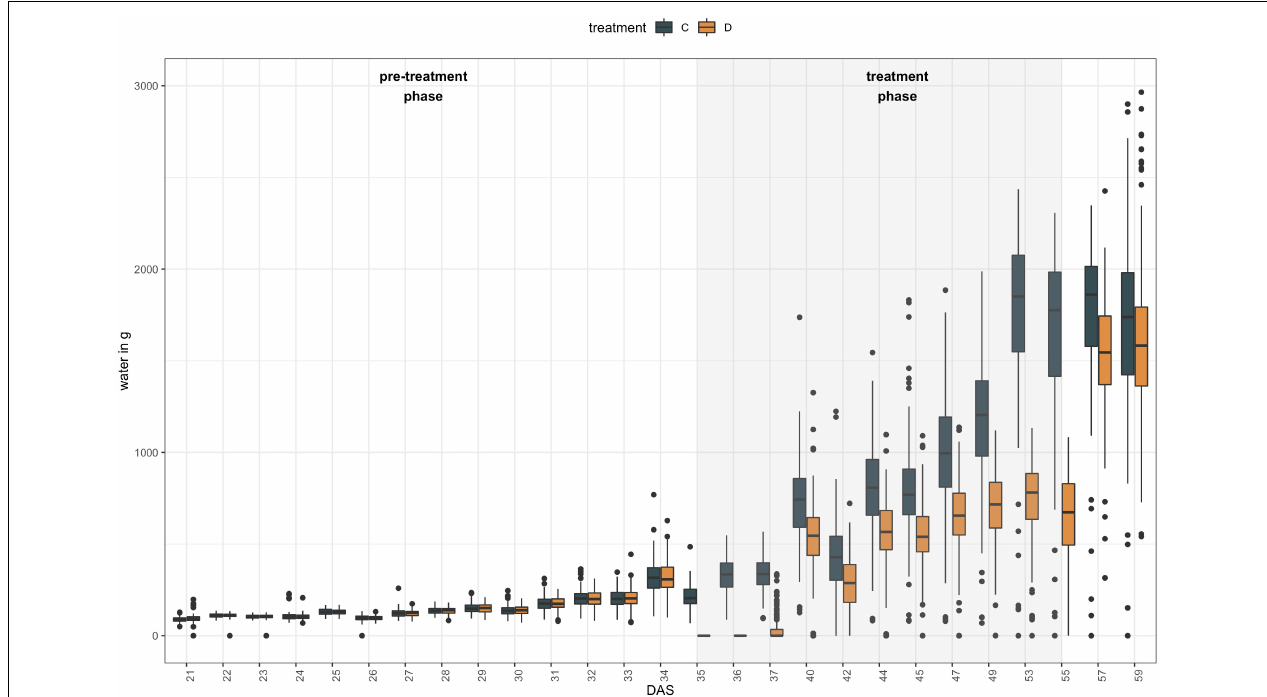
FIGURE 1 | Experimental set-up of high-throughput indoor phenotyping of 50 B. napus founder lines at LemnaTec Scanalyzer 3D facility at University of Nebraska. Six replicates were grown of each genotype and three plants were subjected to one of two watering regimes between 35 DAS and 55 DAS: control plants (C) were kept at 100% field capacity (blue bars), while drought treated (D) plants were maintained at 40% field capacity during that period (orange bars).